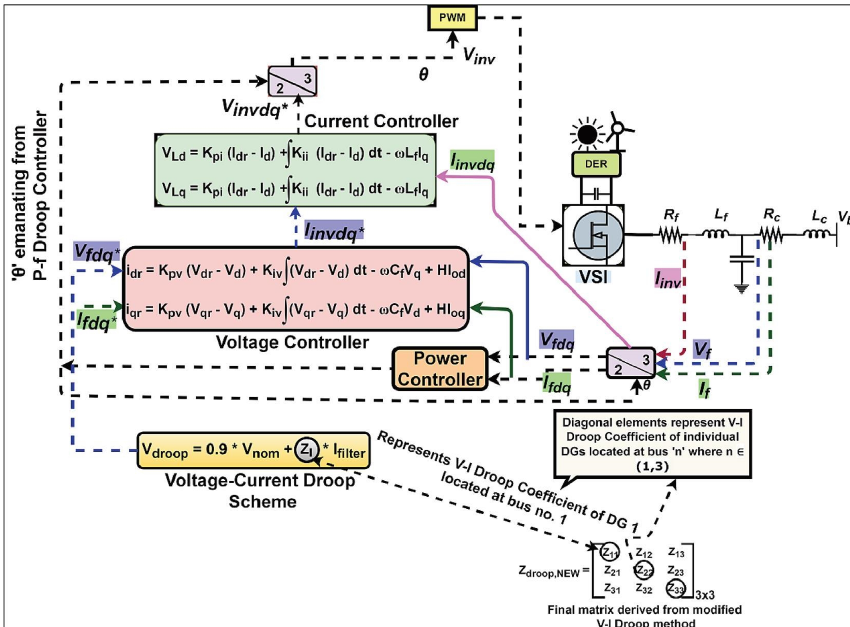
Figure 2: Representation of control framework of stand-alone microgrid.